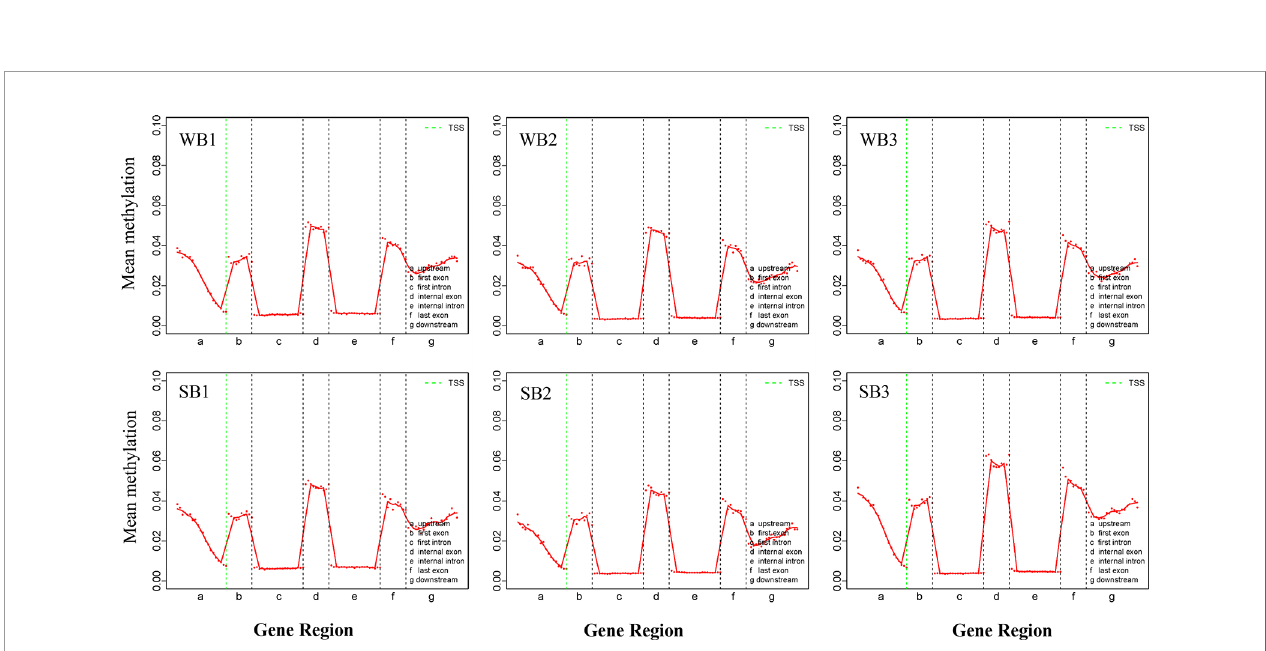
FIGURE 2 | The average ratio of DNA methylation types in the genomes of WB and SB. WB, Winter Bee. SB, Spring Bee. H = A, C, or T. The blue, green, and yellow colors represent mCG, mCHG, and mCHH, respectively.